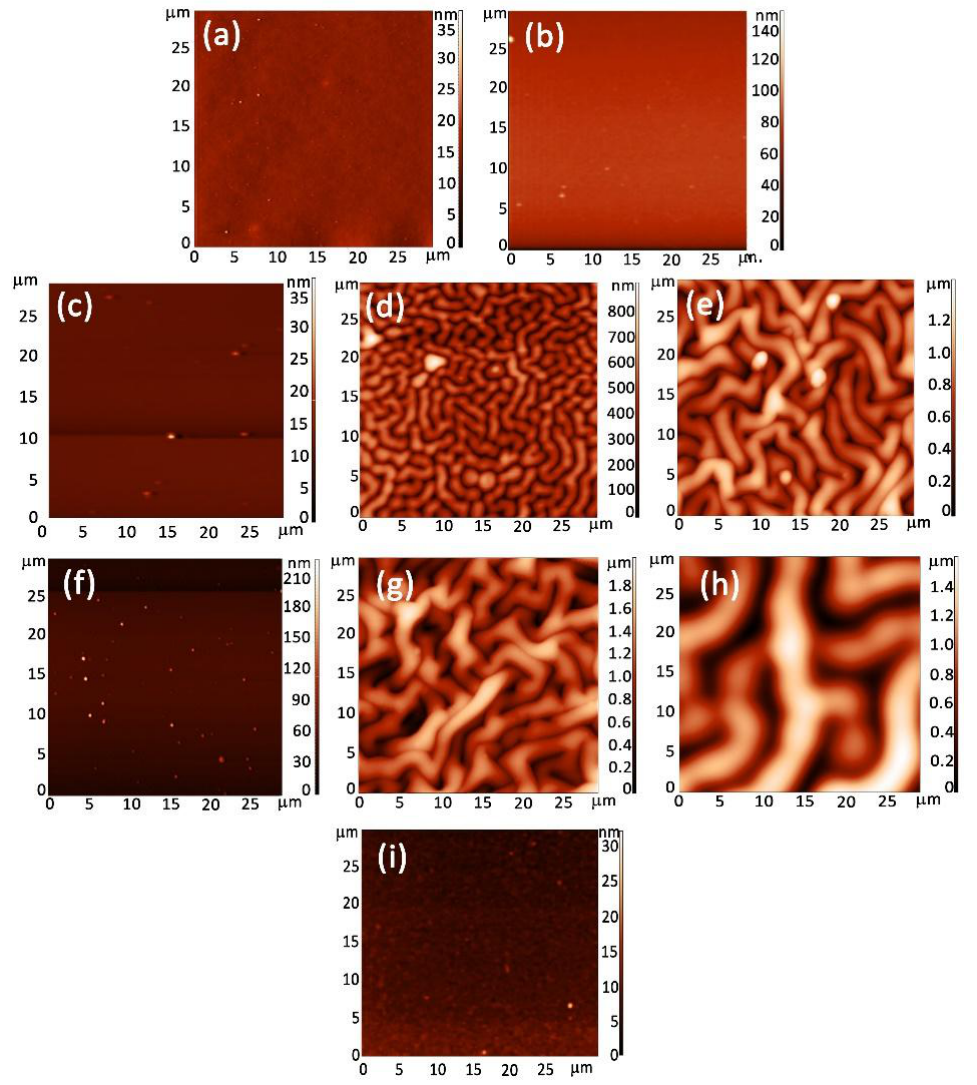
Figure 2. 2D images of ( a ) PANI 1; ( b ) PANI 2; ( c ) PANI 3; ( d ) PANI 4; ( e ) PANI 5; ( f ) PANI 6; ( g ) PANI 7; ( h ) PANI 8; and ( i ) POA polymeric layers.